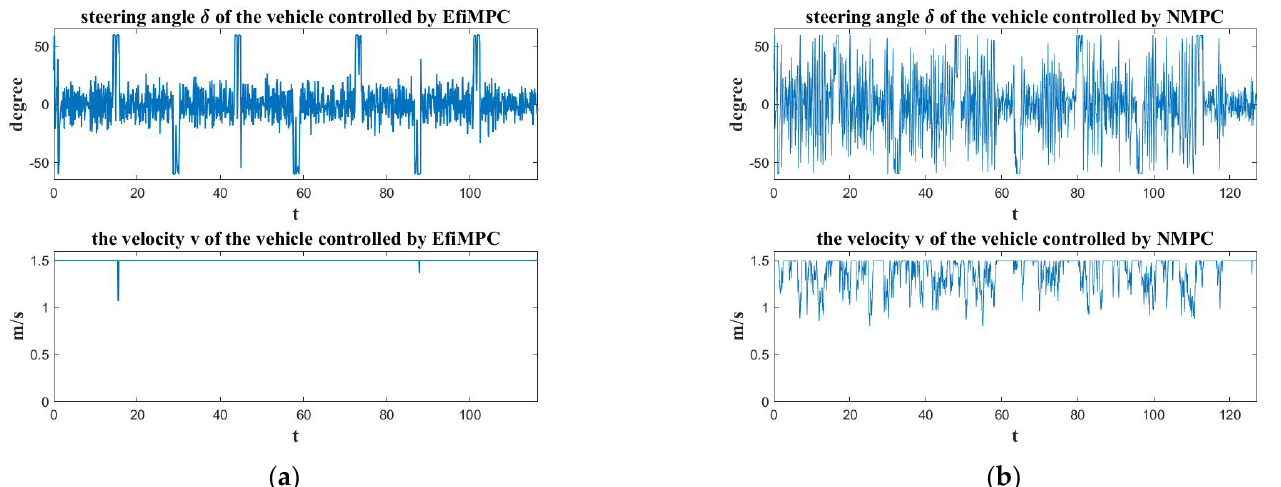
Figure 10. The control actions of autonomous vehicles controlled by ( a ) EfiMPC, and ( b ) NMPC.